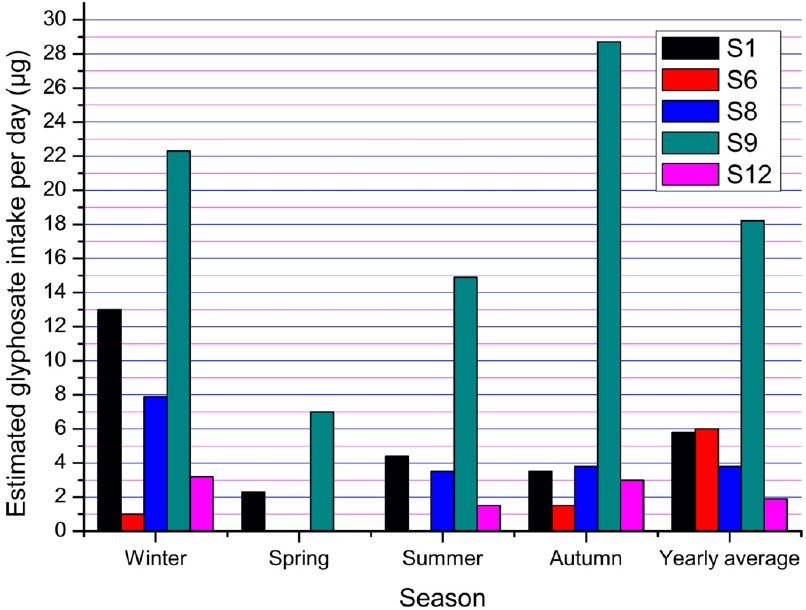
Figure8. Estimationoftheamountofglyphosateintakeperdayaccordingtowateruseandconsumption Figure 8. Estimation of the amount of glyphosate intake per day according to water use and habits at Sampling Sites 1, 6, 8, 9 and consumption habits at Sampling Sites 1, 6, 8, 9 and 12.